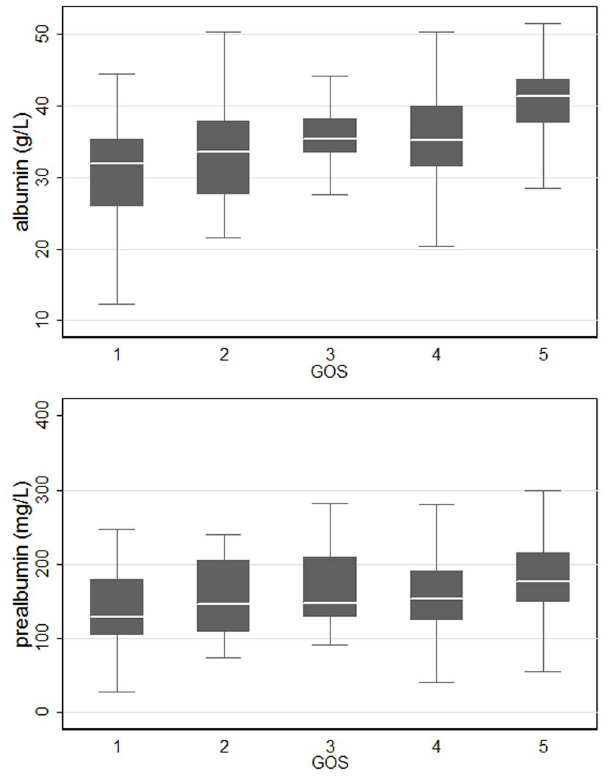
Figure 2. Box plots of serum albumin and prealbumin in GOS subgroups. Serum albumin and prealbumin were both rising with GOS, and the former was more obvious (r albumin =0.518, P , 0.001; r prealbumin =0.314, P , 0.001).